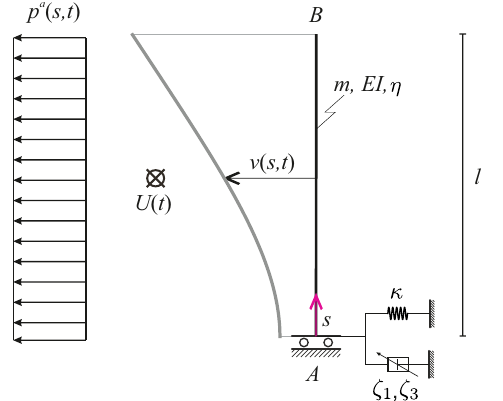
Figure 1. Base-isolated beam model under transverse uniform turbulent wind